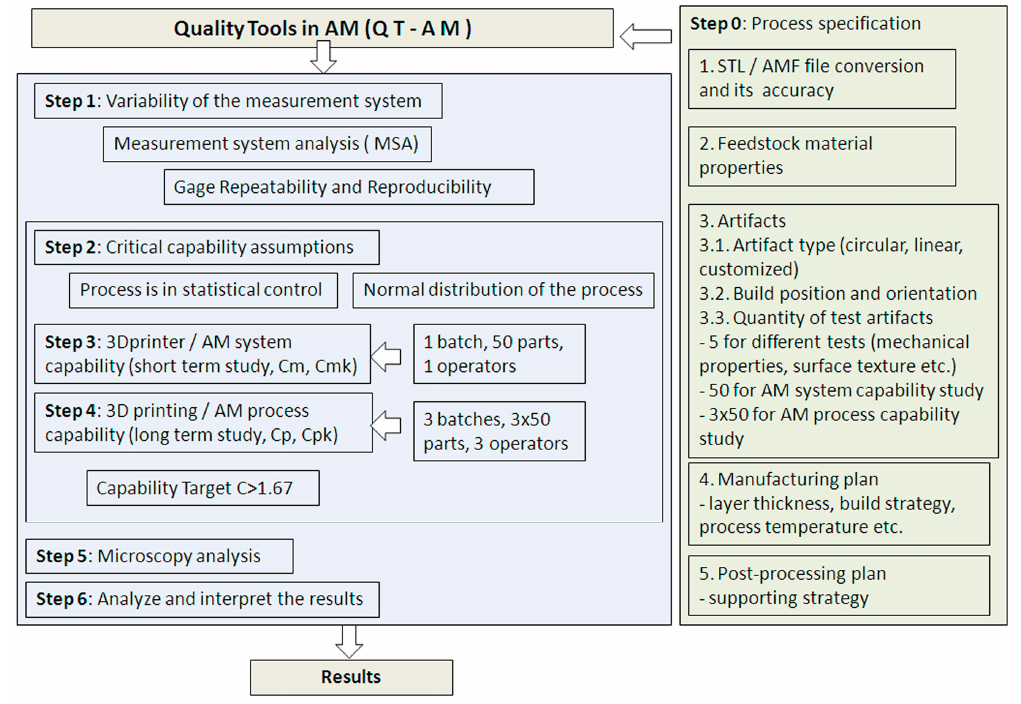
Figure 1. Flowchart of the proposed methodology / procedure named Quality Tools in AM